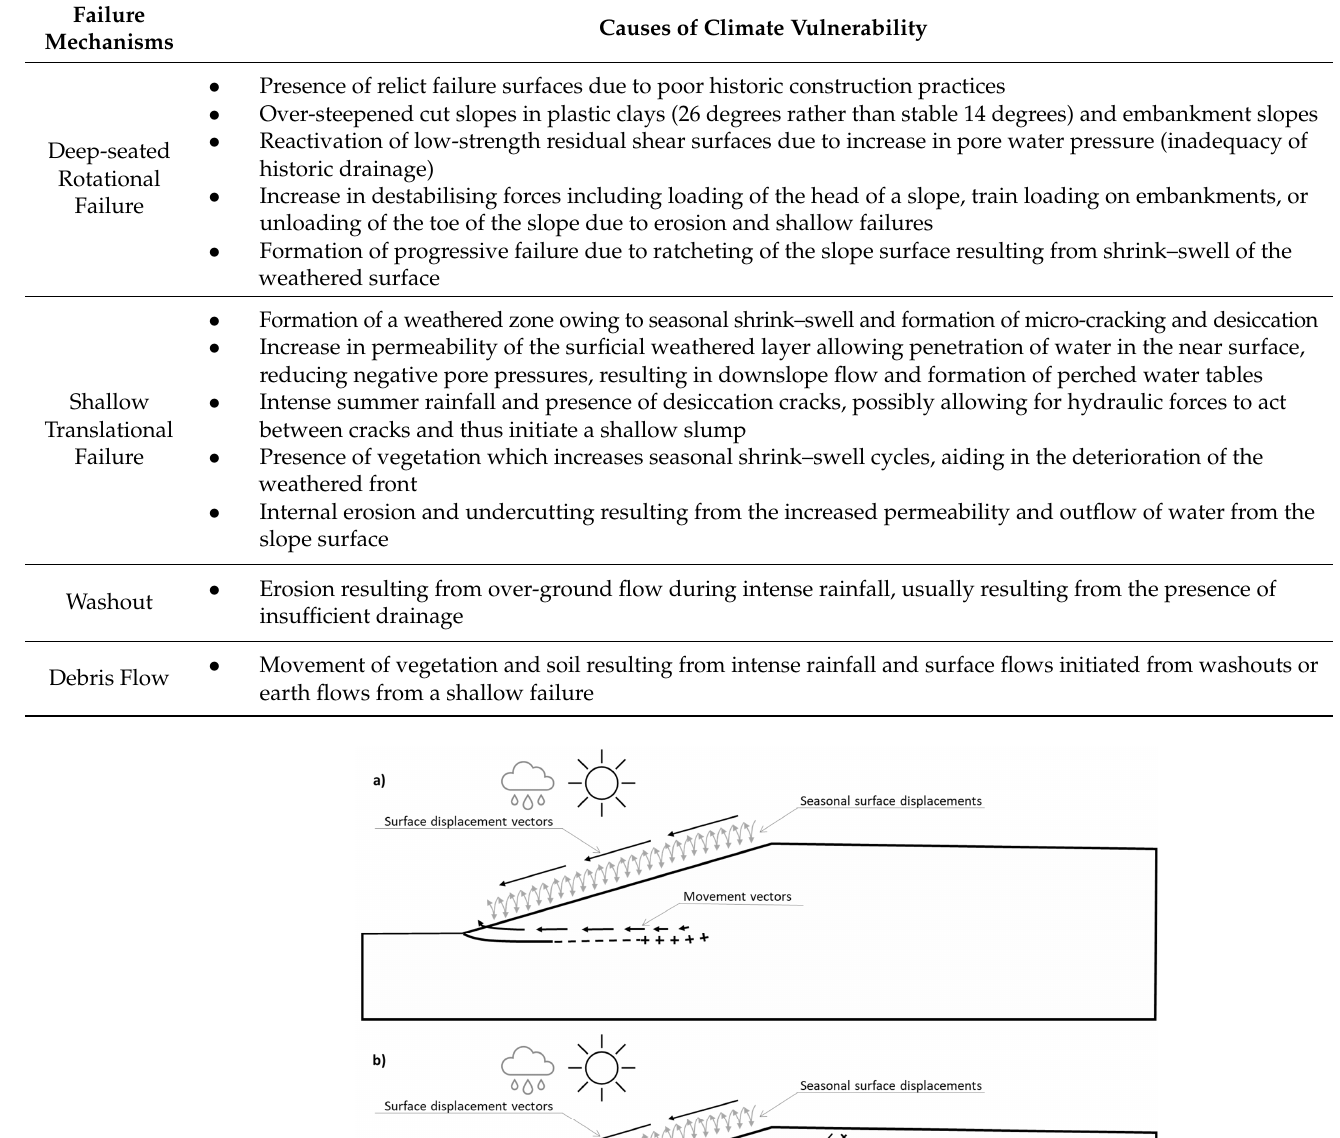
Table 2. Failure mechanism for both embankments and cutting formed in soils in the UK (adapted from Network Rail [9]).